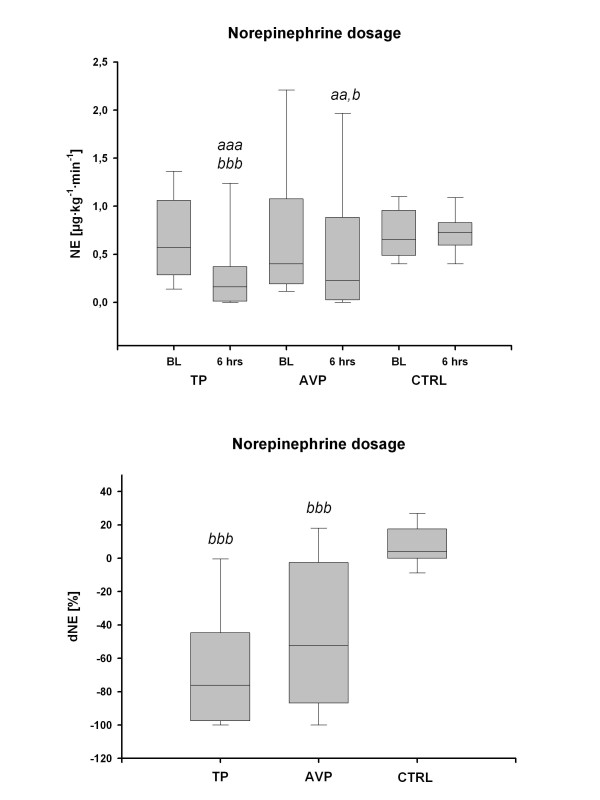
Norepinephrine requirements. The upper panel shows norepinephrine (NE) infusion rates in the terlipressin (TP), arginine vasopressin (AVP) and control (CTRL) groups at baseline (BL) and at 6 hours. The lower panel shows relative NE changes (dNE) after 6 hours compared to baseline in each study group. Solid lines, median; dashed lines, mean; boxes, 25th and 75th percentiles; whisker caps, 10th and 90th percentiles. aaP < 0.01, aaaP < 0.001 vs. BL; bP < 0.05, bbbP < 0.001 vs. controls.